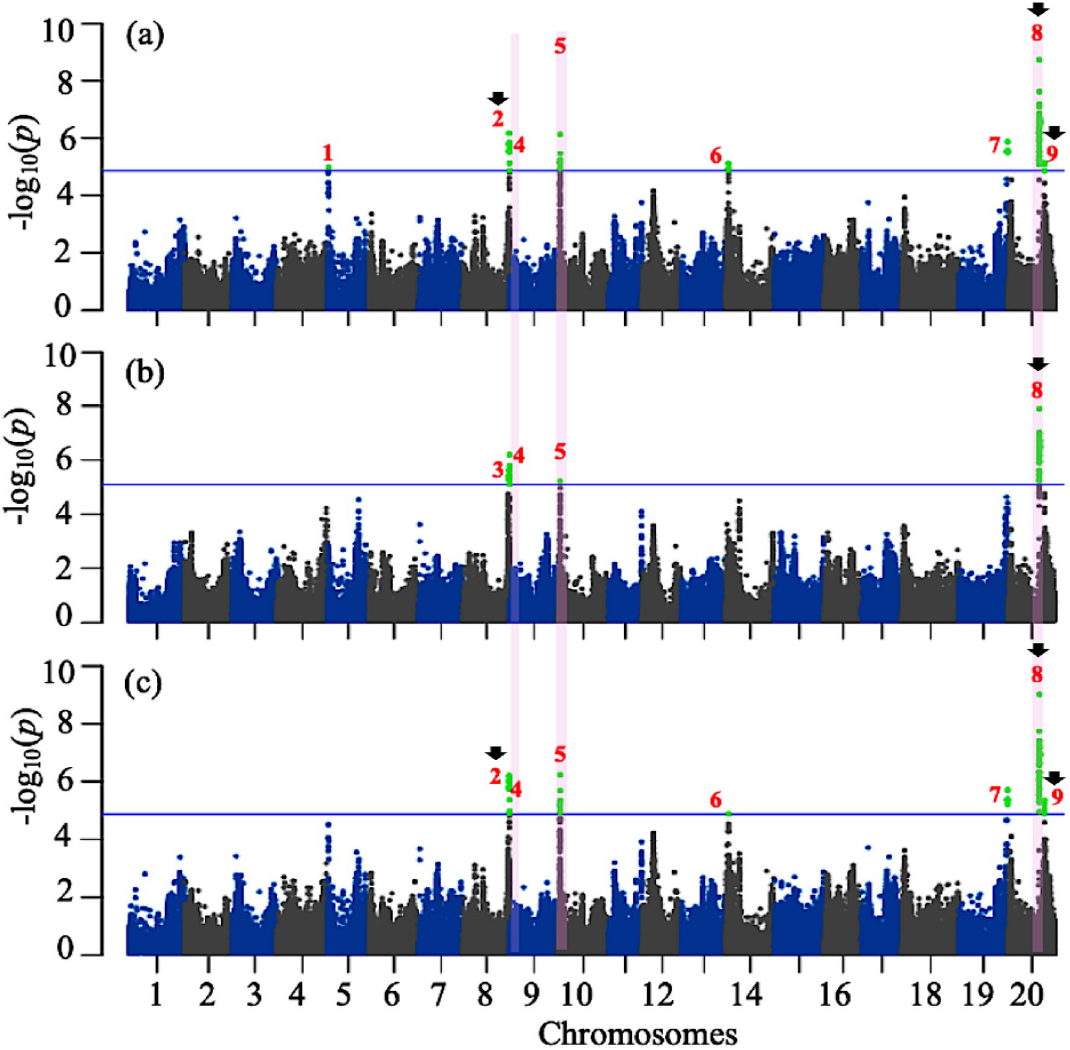
Figure 3. Manhattan plots for ( a ) Cys, ( b ) Met, and ( c ) Cys + Met content in a core set of 137 Canadian soybean accessions using